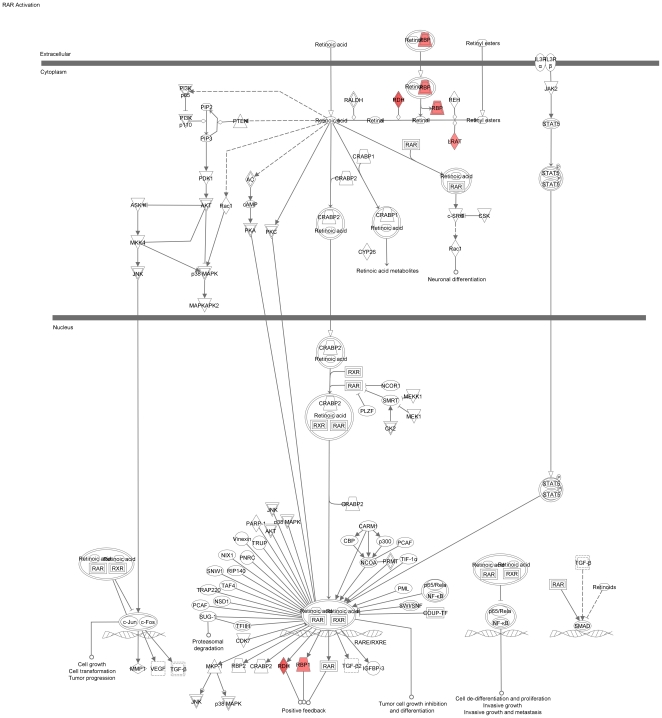
The RAR-activation pathway identified by the Ingenuity software.This is one of the canonical pathways that contains statistically significantly more genes than expected by chance in the group of 114 genes with RPE-specific expression. This figure shows the proteins corresponding to the overrepresented genes. Colored fields indicate their presence among the 114 genes with RPE-specific expression, uncolored genes are added by the software to form pathways. Solid lines between molecules indicate direct physical relationships between molecules (such as regulating and interacting protein domains); dotted lines indicate indirect functional relationships (such as co-regulation of expression of both genes in cell lines).